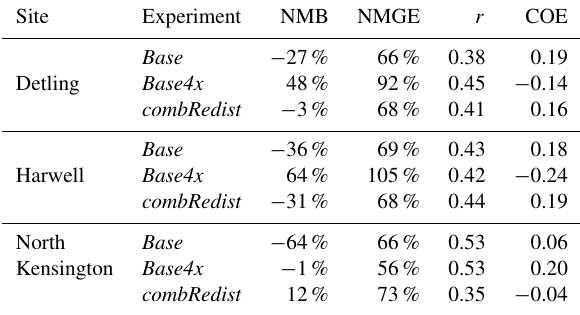
Table 4. Evaluation statistics for modelled vs. measured hourly- average concentrations of SFOA during the ClearfLo winter IOP measurement sites as in Fig. 8, but excluding the period of 13– 18